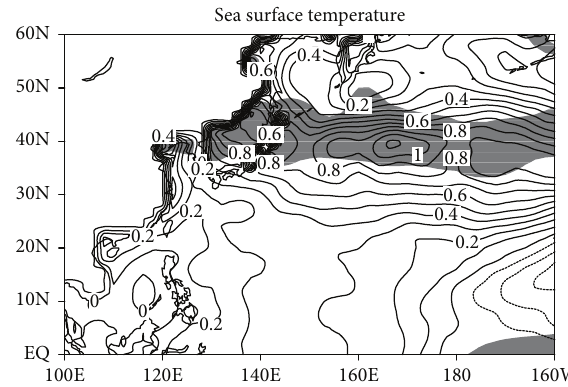
Figure 7: Same as in Figure 3, bur for sea surface temperature. Contour interval is 0.1 ∘ C. Shaded areas are significant at the 95% confidence